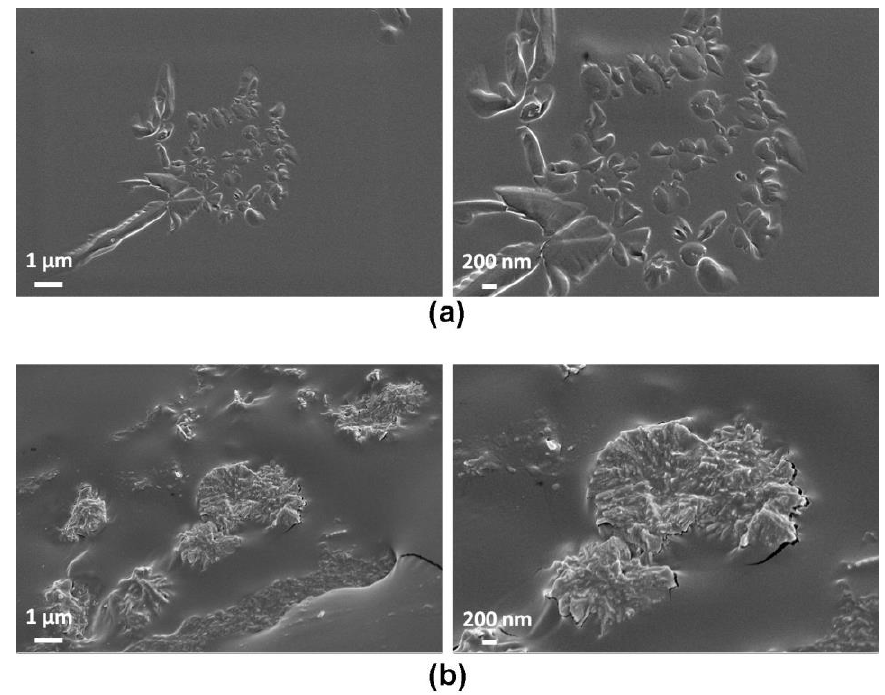
Figure 2. Morphological analysis of polyHEMA@ZnO composite samples incorporating different ZnO amounts: ( a ) ZnO_0.1 wt.%; ( b ) ZnO_1 wt.%.